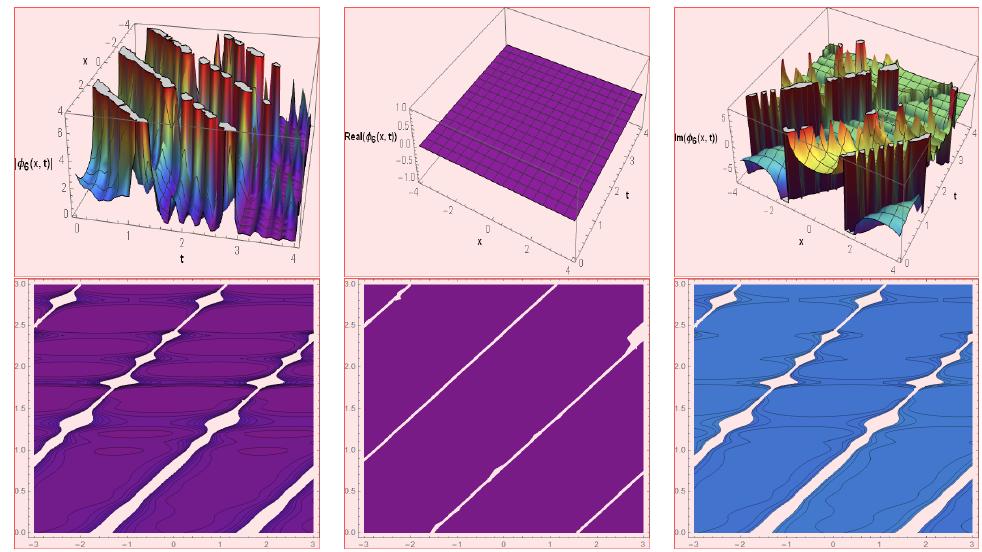
Figure 5. The absolute, real, and imaginary behavior in the shape of 3D and their corresponding contour plots are dispatched for φ 6 ( x , t ) .